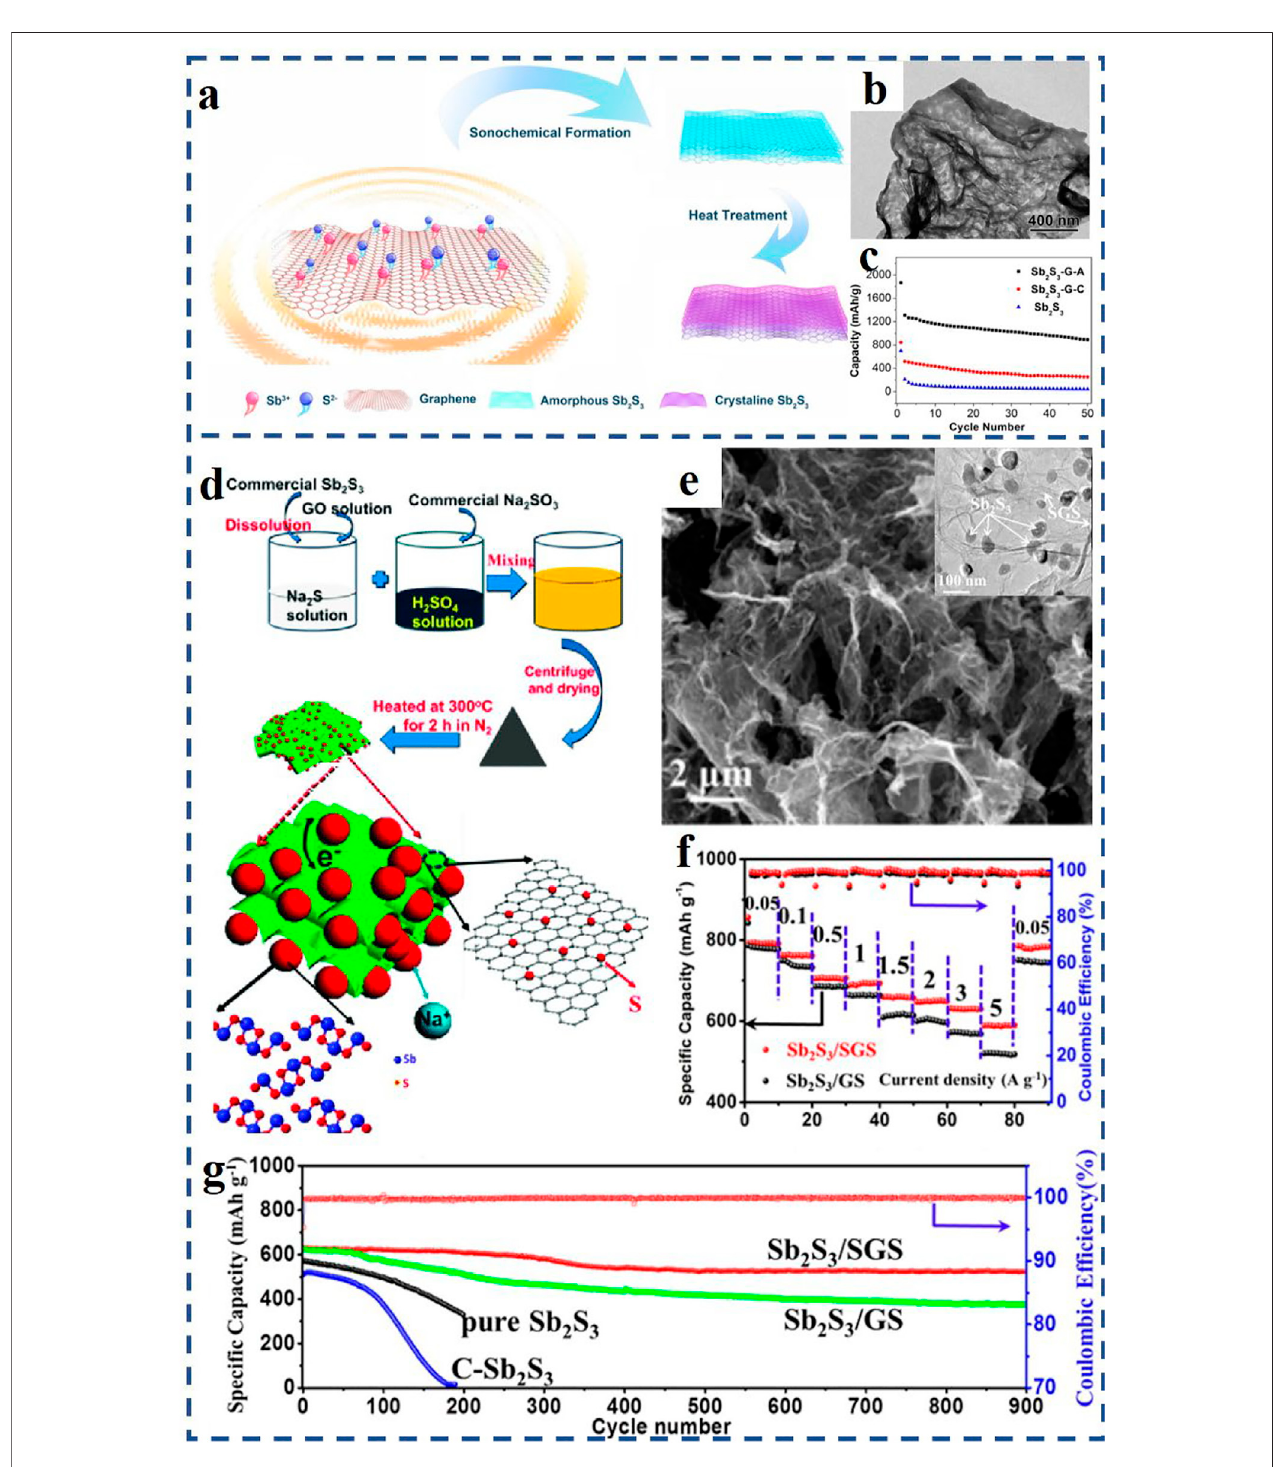
FIGURE2 | (A) Schematic illustration ofthe preparation process of the amorphous and crystalline Sb 2 S 3 /graphenecomposites; (B) TEM image ofthe amorphous Sb 2 S 3 – graphene composites; (C) cycle performances of the pristine Sb 2 S 3 and amorphous and crystalline Sb 2 S 3 – graphene electrodes (denoted as Sb 2 S 3 -G-A and Sb 2 S 3 -G-C); (D) formationprocessoftheSb 2 S 3 /S-dopedgraphenenanocomposite(Sb 2 S 3 /SGS); (E) SEMandTEMimagesoftheSb 2 S 3 /SGSnanocomposite; (F) rate performances of the Sb 2 S 3 /SGS electrode and Sb 2 S 3 – graphene electrode (Sb 2 S 3 /GS) under different current density; (G) cycle performances of three experimentalelectrodesat2 A g − 1 . (A – C) ReproducedwithpermissionfromZhaoetal.(2021).Copyright2020,Elsevier. (D – G) ReproducedwithpermissionfromXiong et al. (2016), Copyright 2016, American Chemical Society.